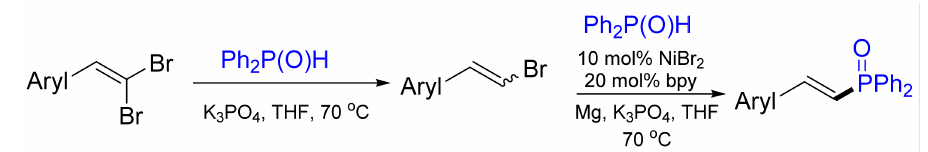
Figure 21. Reaction of alkenyl bromides with diphenylphosphane oxide.